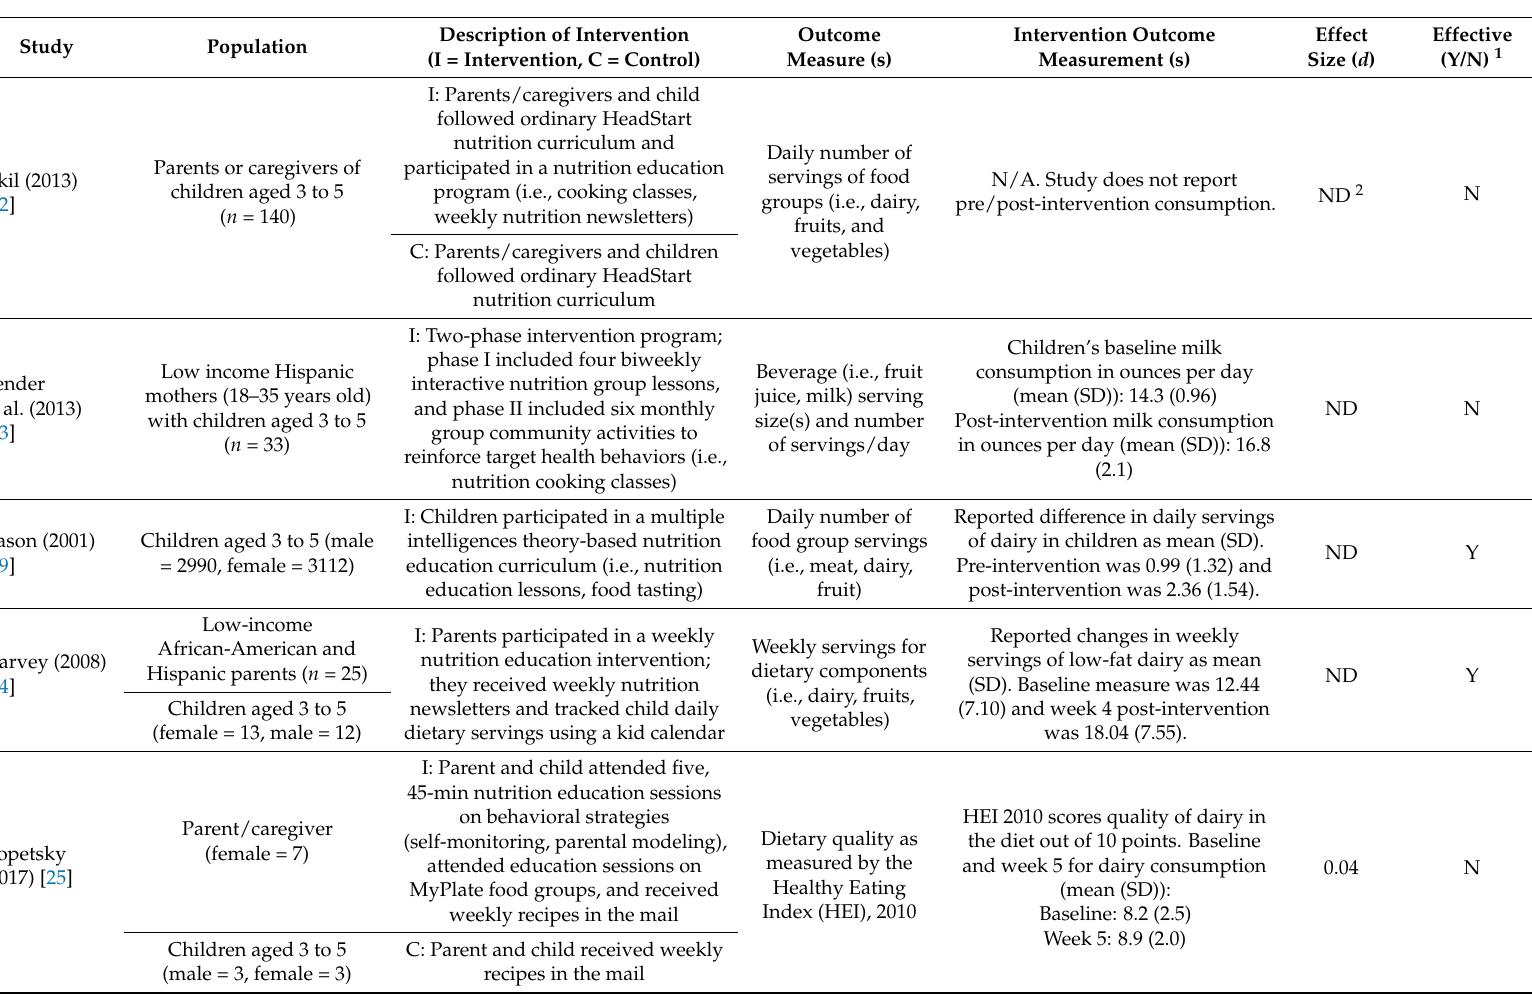
Table 1. Dairy and calcium intervention studies targeting preschool-aged children: study data extraction table with effect size ( d ) and intervention effectiveness. Study Population